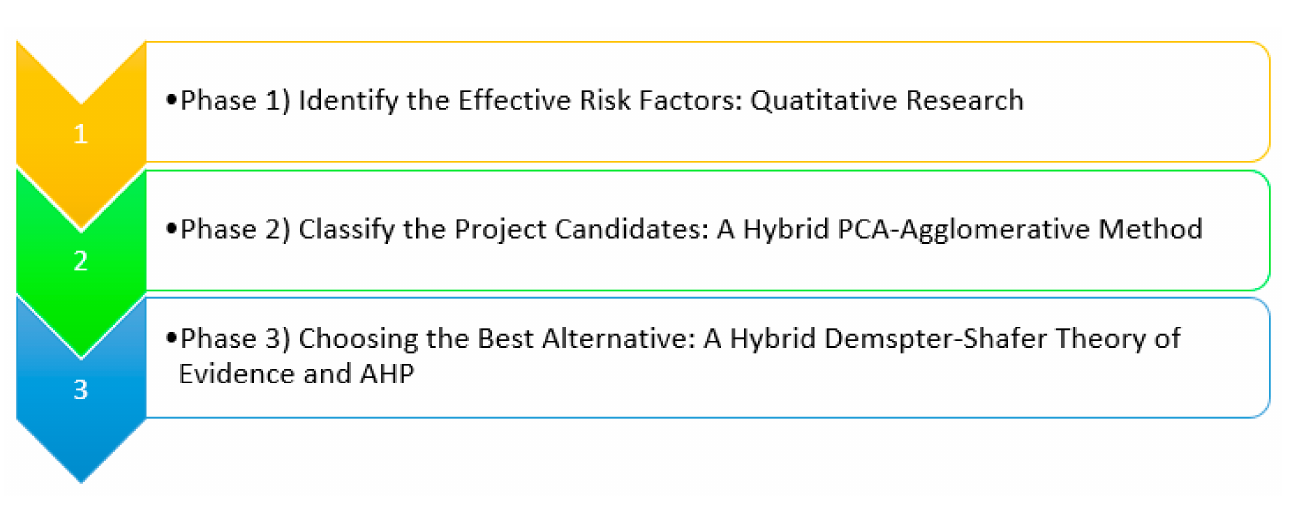
Figure 3. Each phase of the proposed method.